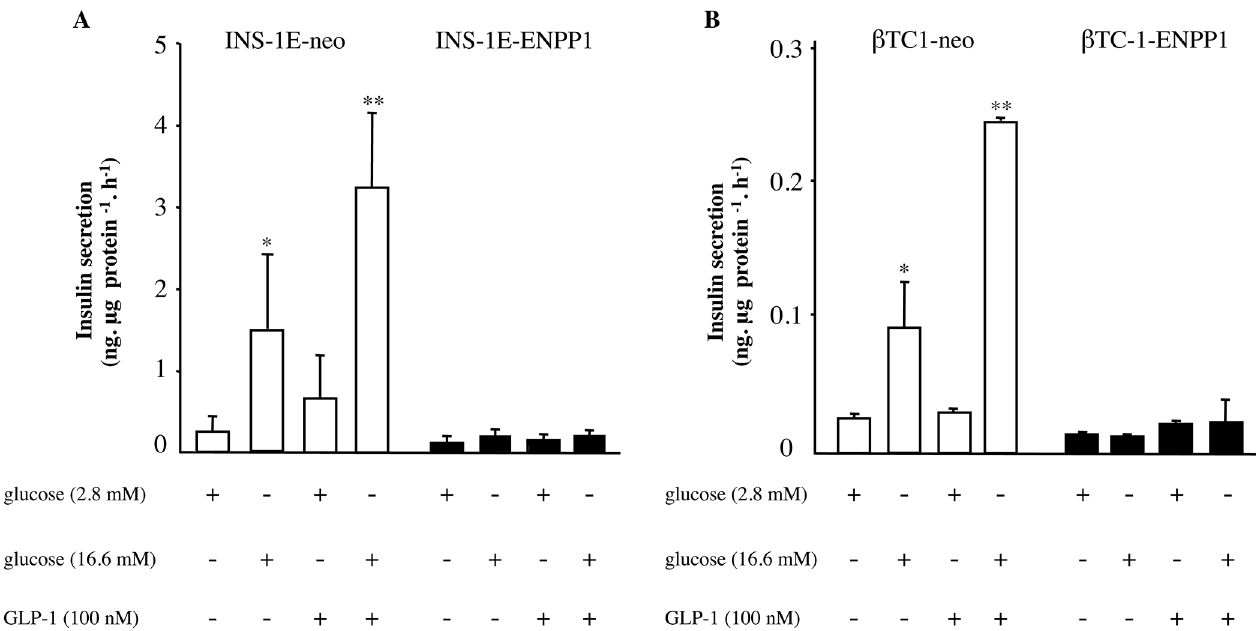
Fig 1. GLP-1 fails to increaseinsulin secretion in ENPP-1 transfected cells. INS-1E (panelA) and β TC-1 (panelB) cells, either transfected with neomicine(neo) or ENPP1 gene variant, were exposedto 100 nmol/l GLP-1 (60 min, 37˚C) and glucoseinducedinsulinsecretion measured. Valuesare expressedas means ± S.D. of five independentexperiments; * p < 0.05comparedto neo-transfected cells at 2.8 mmol/l glucose; ** p < 0.05comparedto neo cells at 16.6 mmol/l glucose.